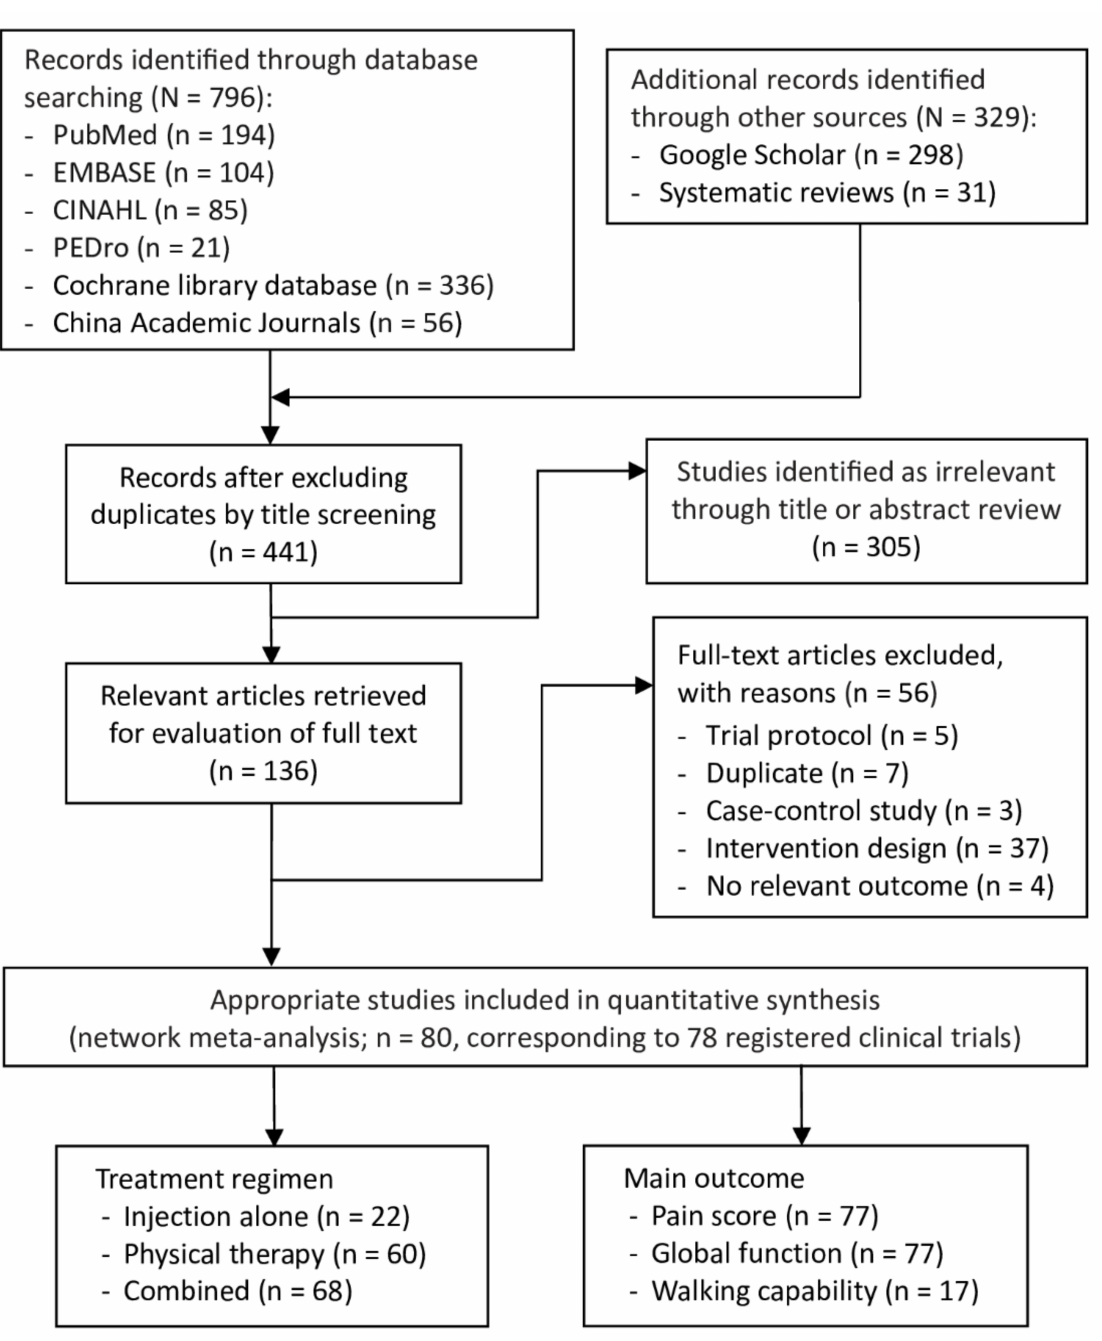
Figure 1. PRISMA flowchart of the study